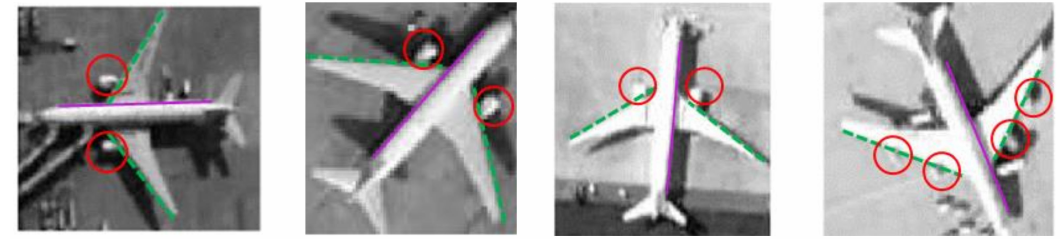
Figure 7. The main features of civil